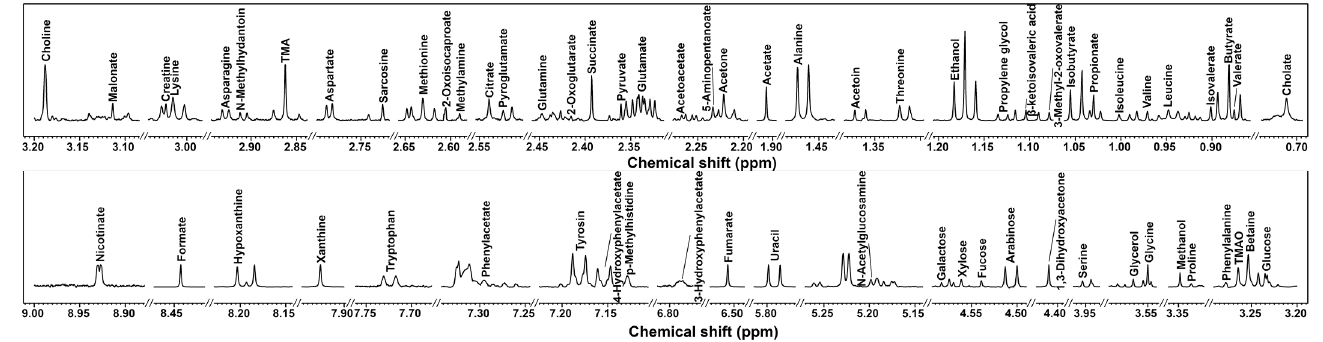
Figure 2. 1 H-NMR spectrum of cecum contents in mice. Molecule names that appear over the signal were used for their quantifications. For each portion, a spectrum with a convenient signal-to-noise ratio has been selected in order to ease the reader’s visual inspection.